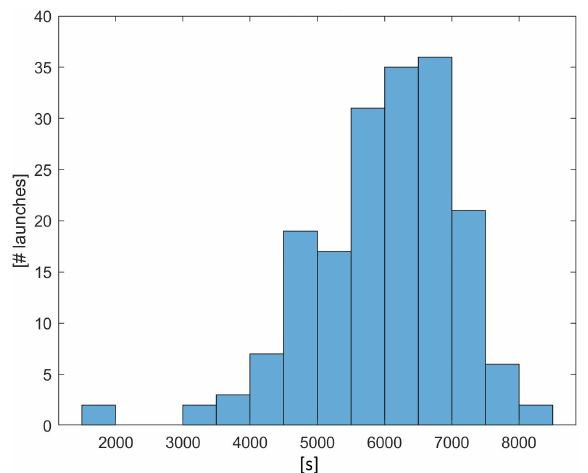
Figure 6. Frequency distribution of profile duration in the Few_nan data